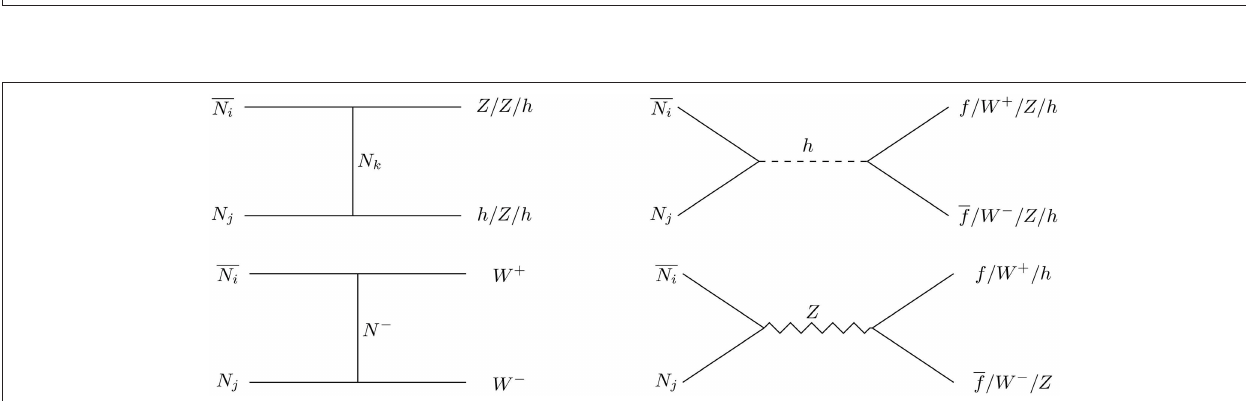
0.2 (Maroon color). In the right panel, allowed values of ˆ T is plotted in m N = 0.2 (Maroon color).